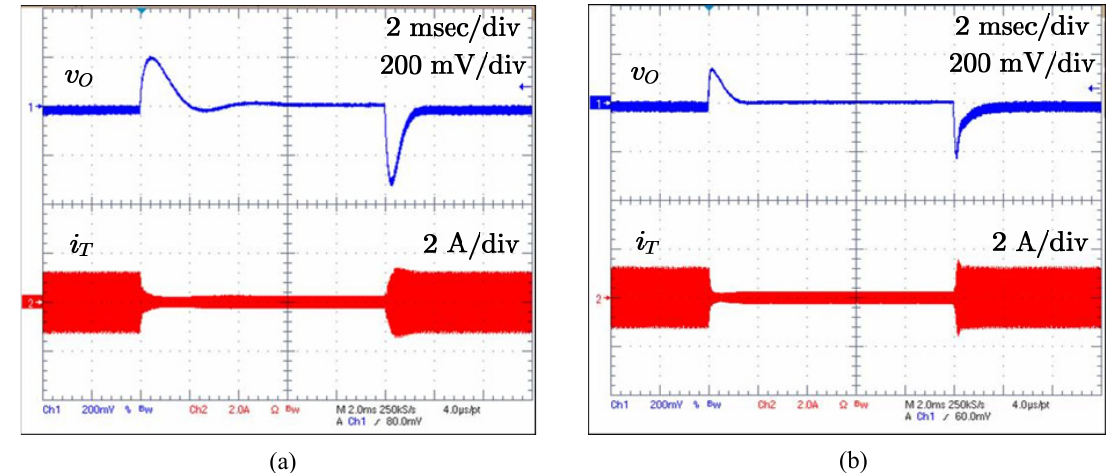
Figure 11. Step-load transient response waveforms of voltage mode control and proposed current mode control. ( a ) Voltage mode control; ( b ) Current mode